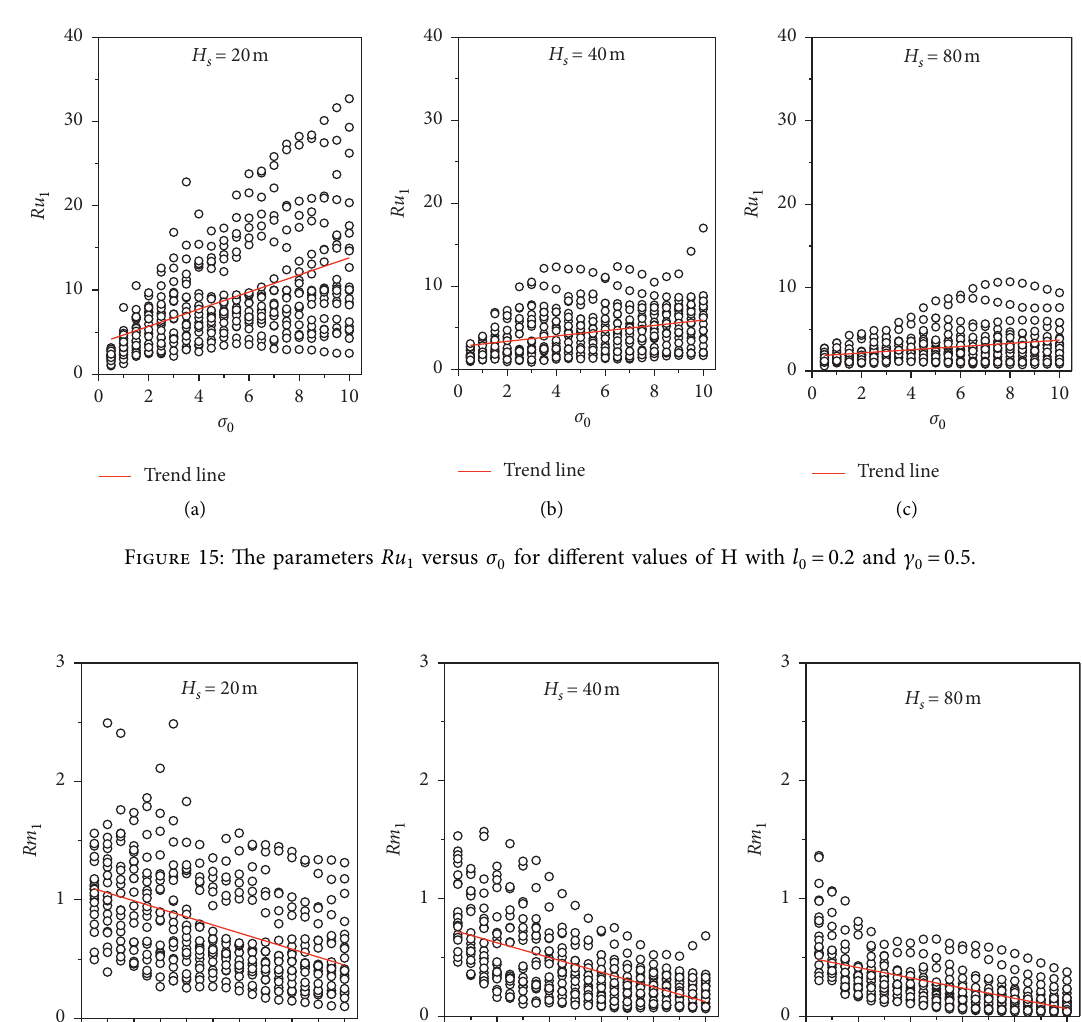
Figure 16: The parameters Rm